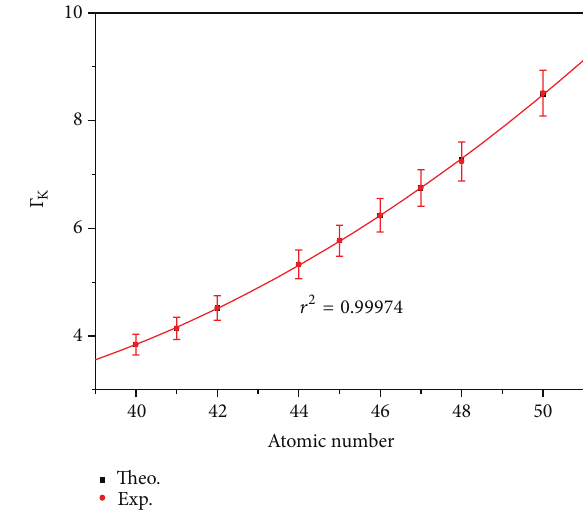
Figure 8: The variation in Γ